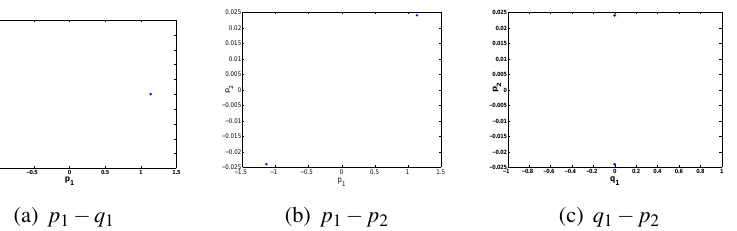
Fig. 2 Section of global random basic attractors for ϕ NGM 3 with case II